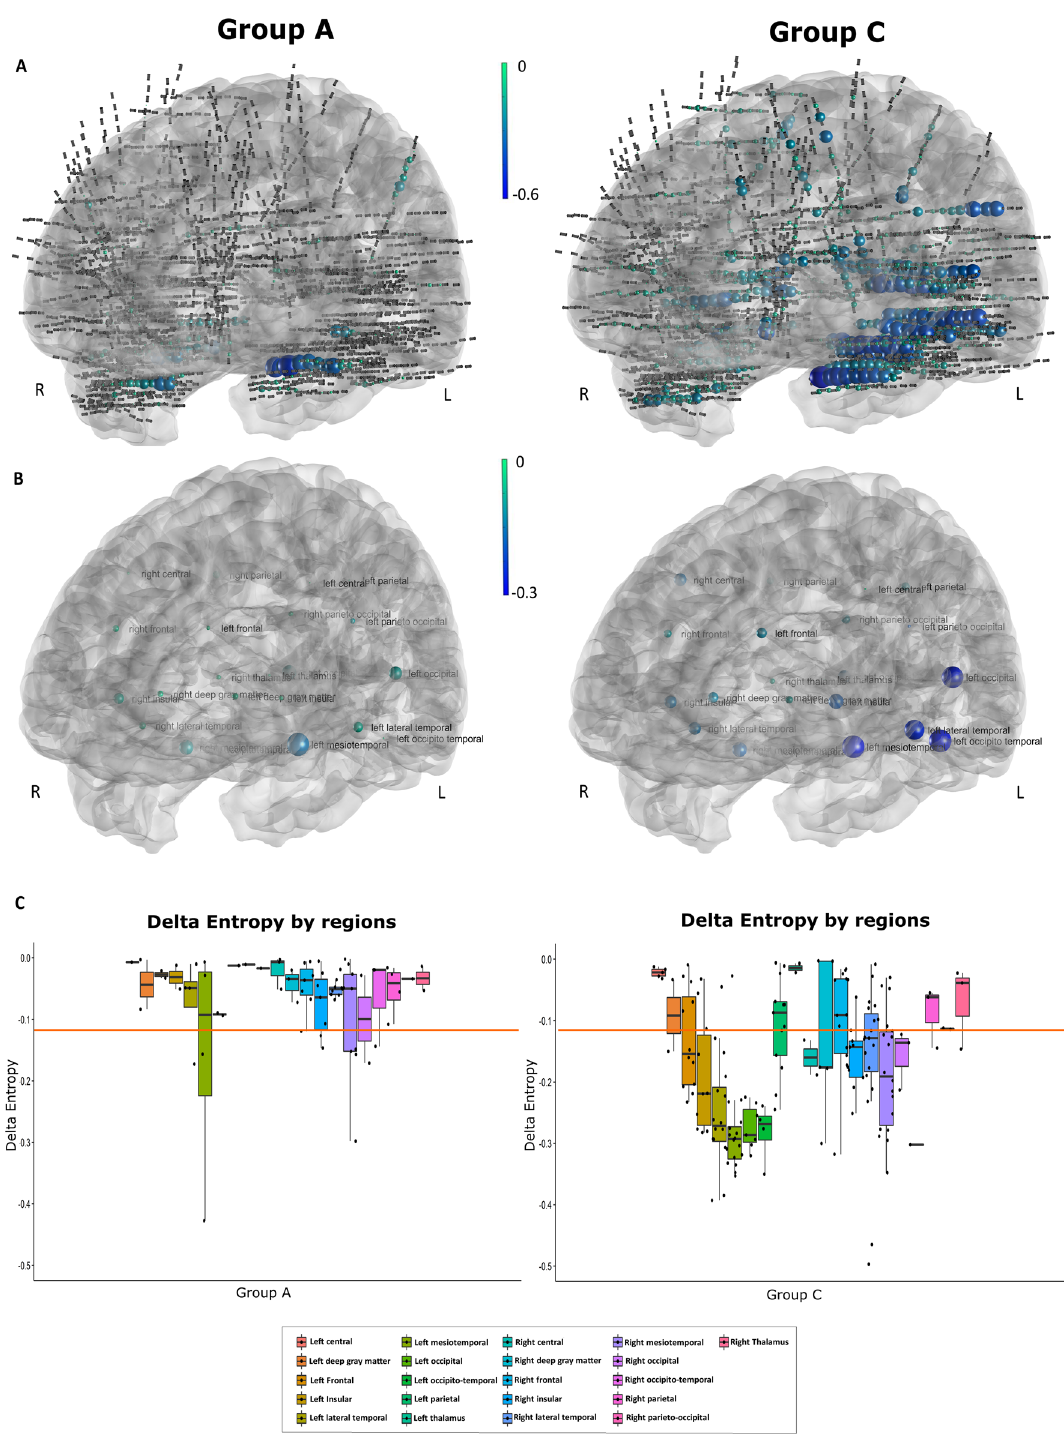
Figure 4. Visualization of the delta entropy values inside the brain. ( A ) Stereotactic-EEG electrodes of all subjects are projected into MNI template using GARDEL 22 software allowing a 3D vision of the contacts. Then delta entropy value by contact for Group A and C are visualized, the size and the color being proportional to the values. ( B ) Visualization of delta entropy by anatomical regions for Group A and C. ( C ) Distribution of delta entropy values by anatomical regions with the threshold at − 0.135 (in